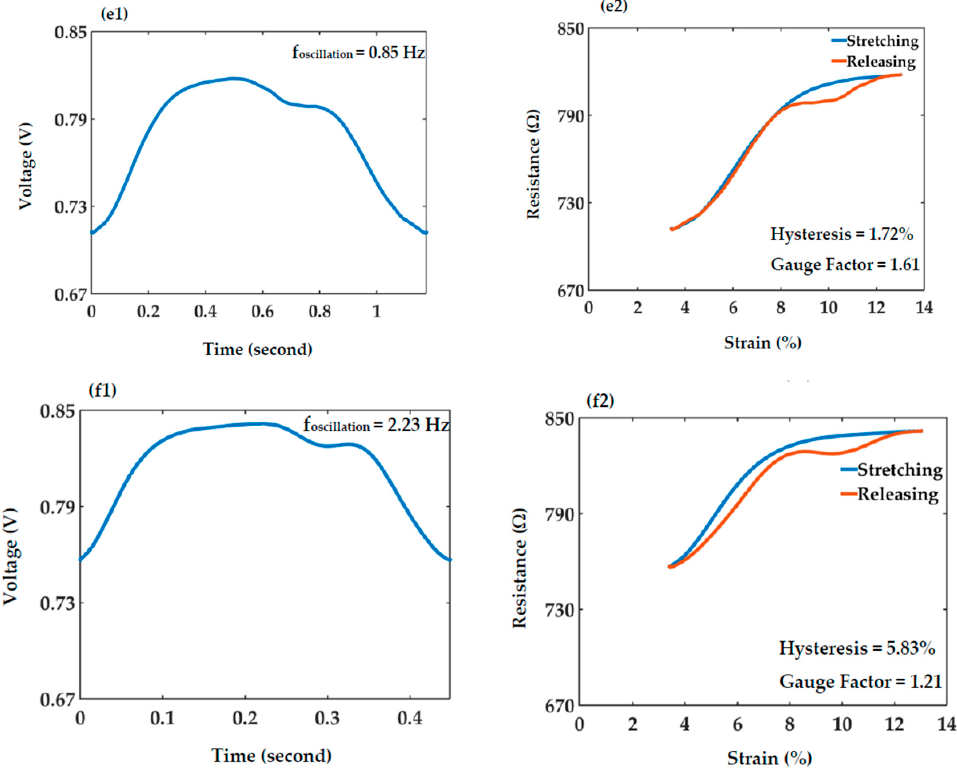
Figure 8. (a1 , b1 , c1 , d1 , e1 , f1 ) show the average temporal response calculated for oscillation frequencies of 0.05 Hz, 0.15 Hz, 0.26 Hz, 0.59 Hz, 0.85 Hz, 2.23 Hz respectively; ( a2 , b2 , c2 , d2 , e2 , f2 ) show the hysteresis behavior of the ERB sensor for oscillation frequencies of 0.05 Hz, 0.15 Hz, 0.26 Hz, 0.59 Hz, 0.85 Hz, 2.23 Hz respectively. Hysteresis is calculated at the midpoint of minimum and maximum strain. Gauge factors are also calculated for each oscillation frequency.